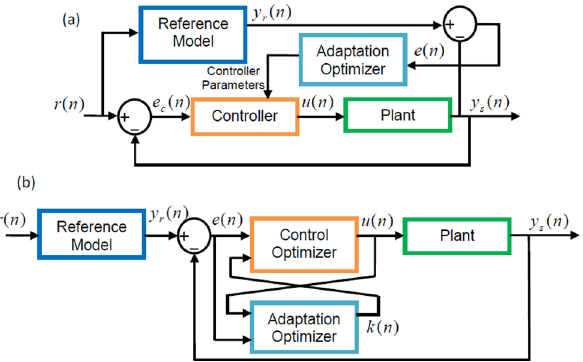
Fig 1. (a) Block diagrams of conventional MRAC system, (b) block diagrams of RSAC system.